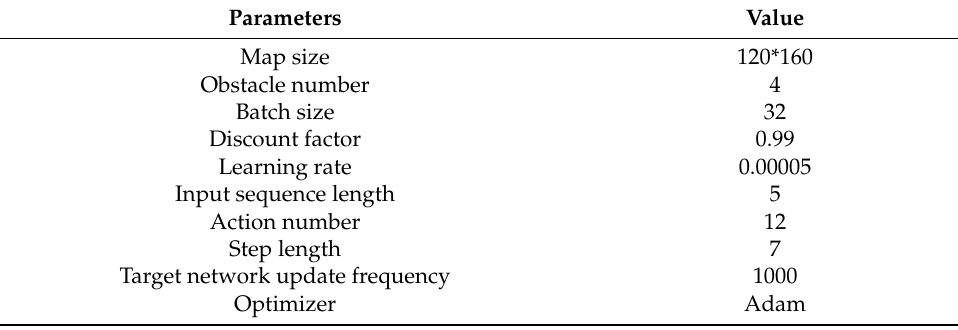
Figure 8. The random obstacle generation for training the path planner. ( a ) Random obstacle case 1, ( b ) Random obstacle case 2, ( c ) Random obstacle case 3, ( d ) Random obstacle case 4. Table 5. Hyperparameters of Training the Global Path